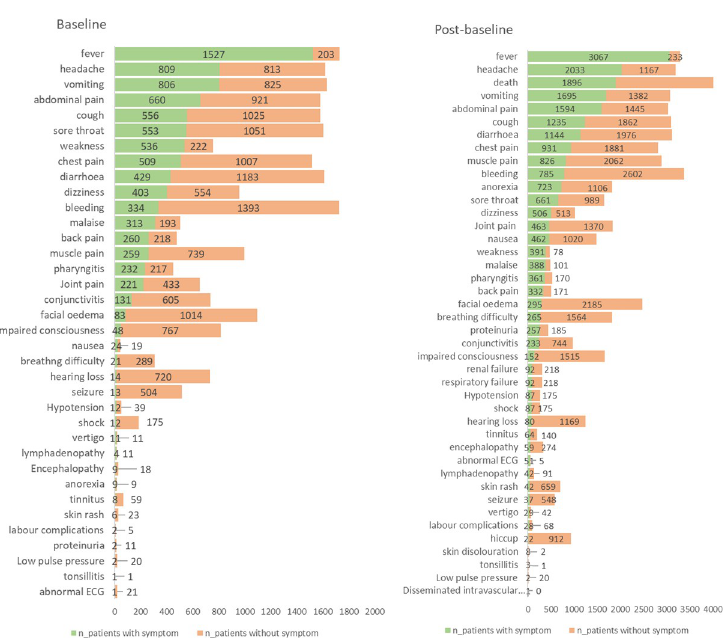
Fig 4. Clinical signs and symptoms reported at baseline and post-baseline by proportion of individuals with and without sign/symptom.